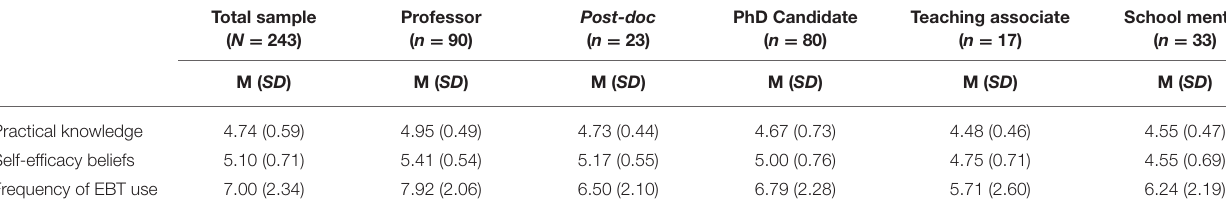
TABLE 3 | Descriptive statistics for all variables based on teacher educators’ research